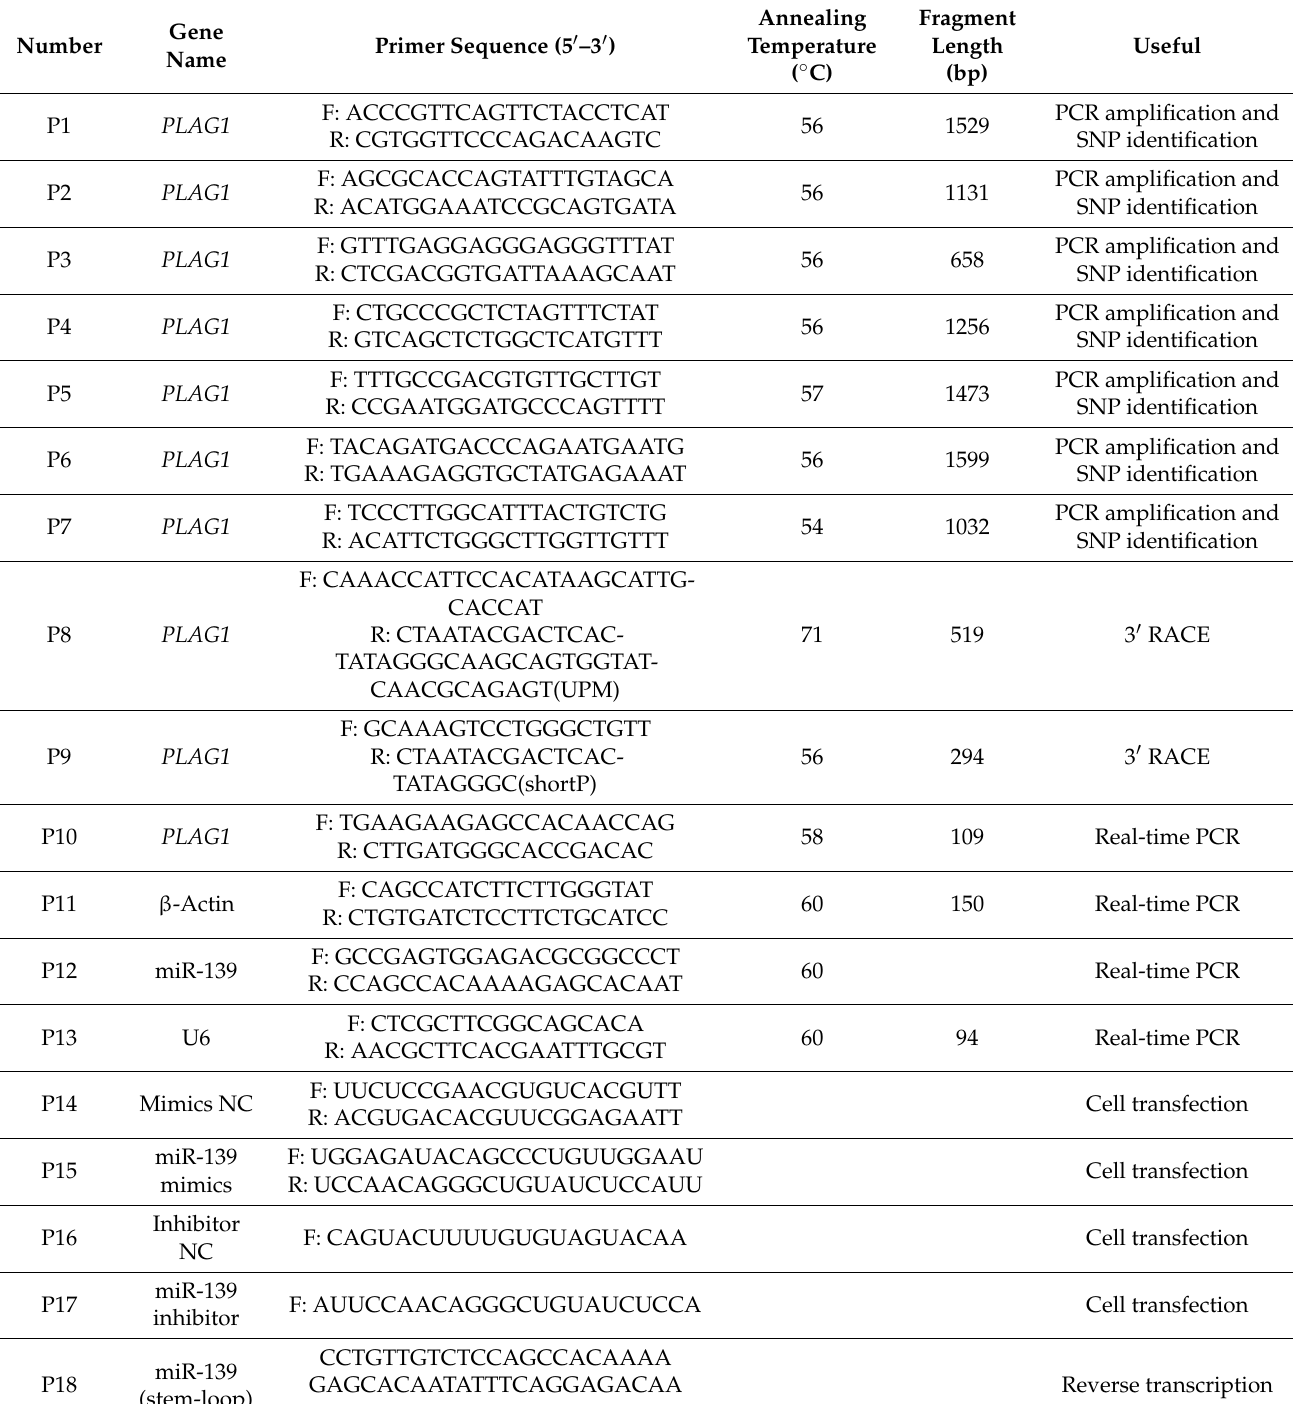
Table 1. List of primers and oligonucleotides used in this